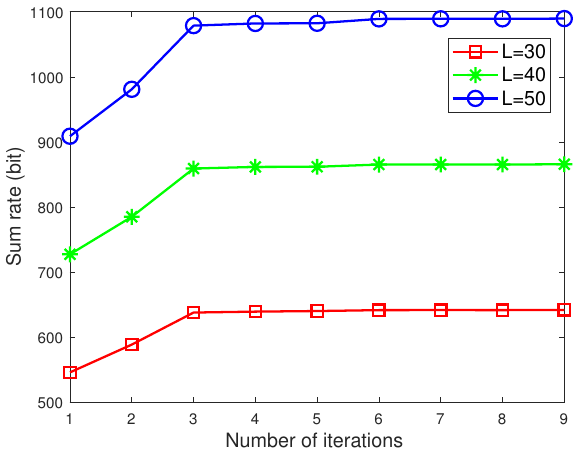
Figure 7. The sum rate w.r.t. the number of